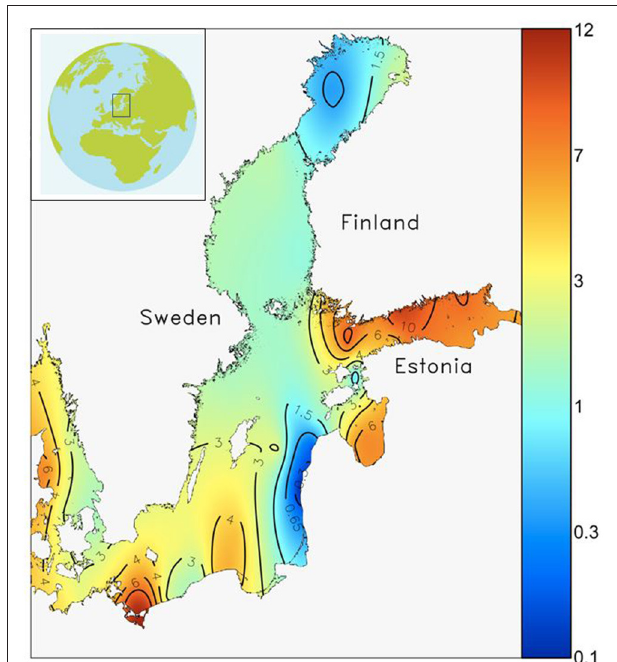
FIGURE 1 | Spatial variability of the spring bloom peak biomass (wet weight, mg L − 1 ) in the Baltic Sea. High biomass ( > 6mg L − 1 ) is found in the most eutrophied basins (e.g., Gulf of Finland), mid-level biomass (1.5–3mg L − 1 ) is found in the larger basins (e.g., Northern Baltic Proper, Bothnian Sea) and low biomass ( < 1.5mg L − 1 ) is found in the most oligotrophic parts (e.g., Bothnian Bay) of the Baltic Sea. The map has been modified from Klais et al.